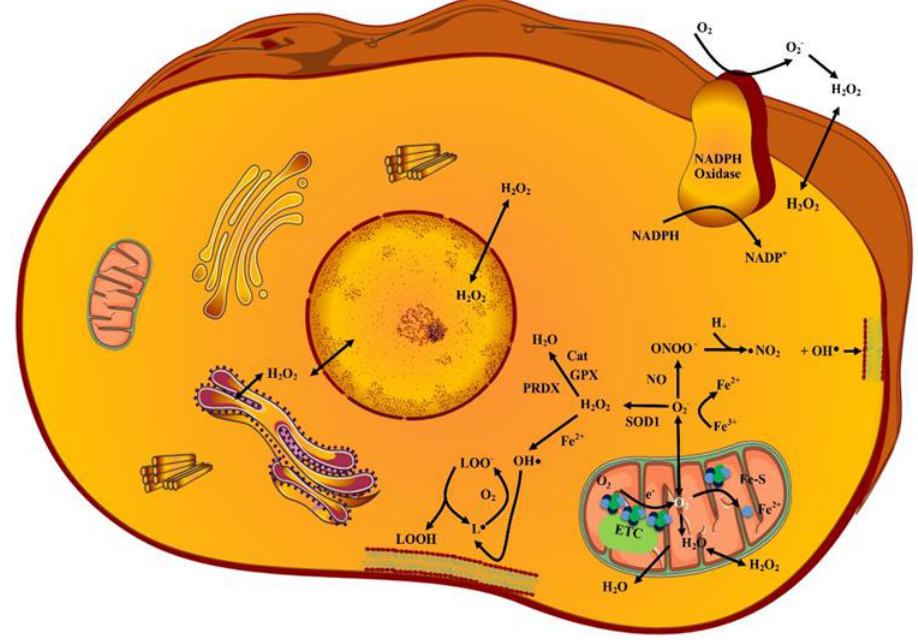
Figure 1. Various types of reactive oxygen species (ROS) and their